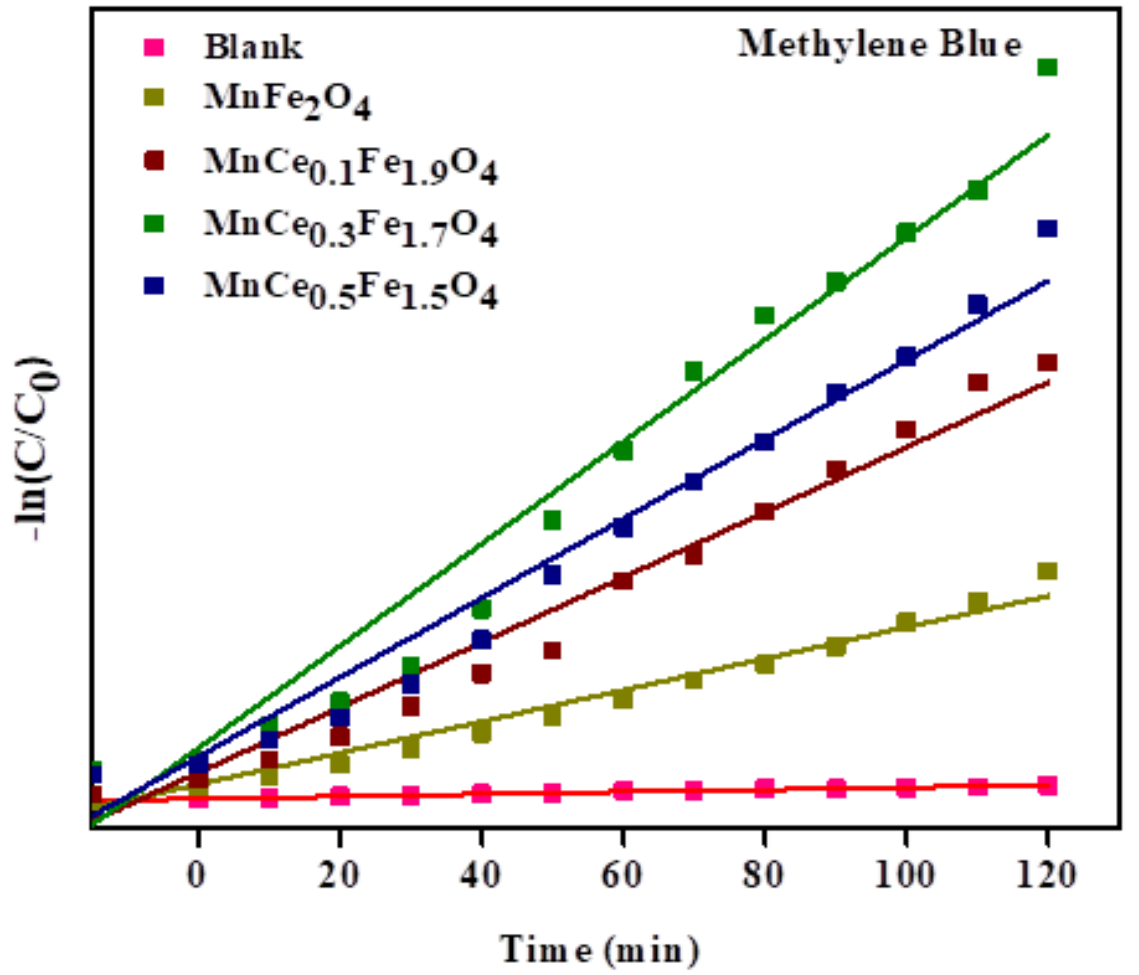
Table 4. Rate of constant k abs value for the degradation of RhB on spinel MnCe x Fe 2 − x O 4 (x = 0.0, 0.1, 0.3 and 0.5) NCs.